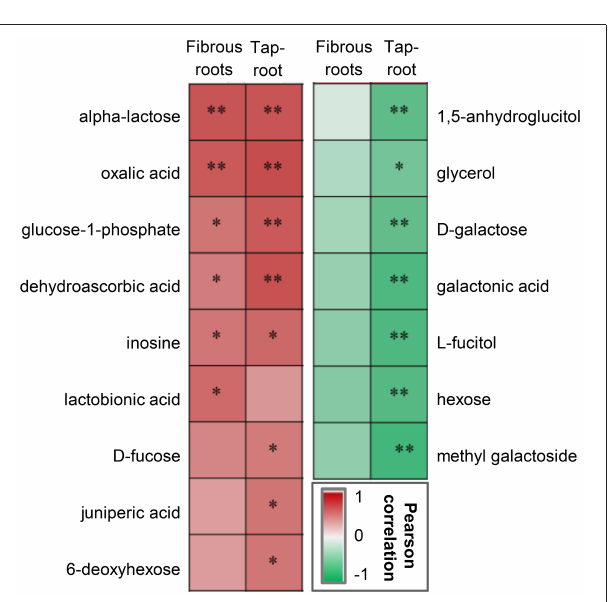
FIGURE 5 | Pearson correlation analysis between DAMs and ginsenosides in the fibrous roots and taproots of P. notoginseng . *Indicates a significant correlation at p < 0.05 and **indicates a significant correlation at p < 0.01. The red box represents a positive correlation, the green box represents a negative correlation, and the depth of the color represents the degree of